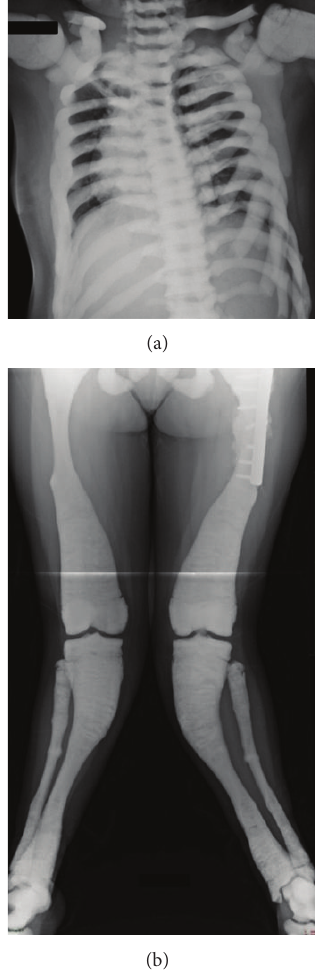
Figure 1: X-rays of patient S7 at the last followup showing right scoliotic deviation of the dorsal spine, knee valgus, and deviation of the tibia with multiple fractures of the tibia and